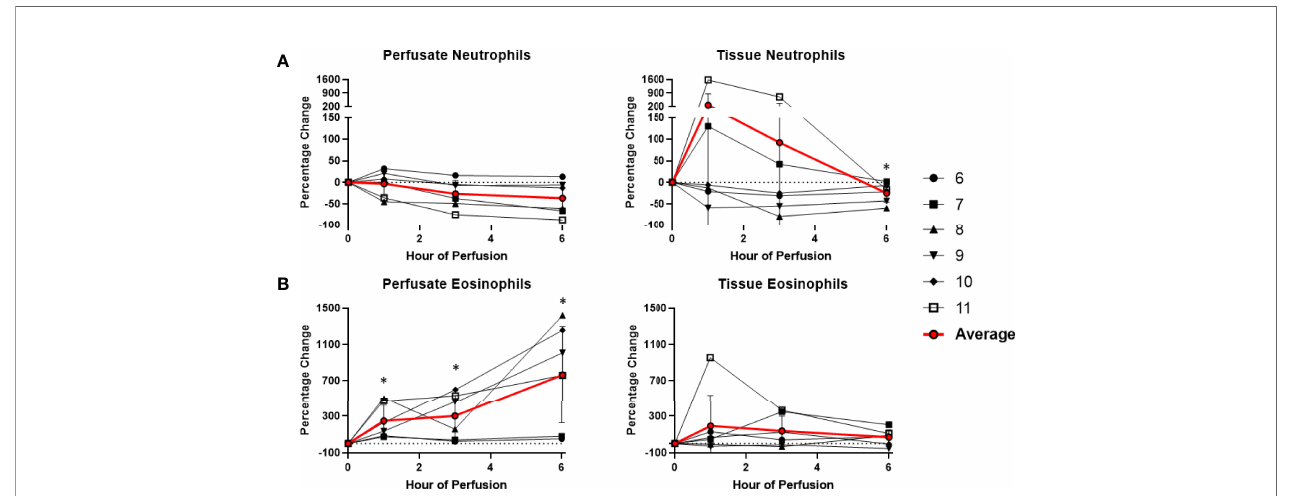
FIGURE 8 | Percentage change of frequency of cells from granulocyte lineage during perfusion. A percentage change of 0% suggests there is no change in the innate immune cell frequency from time point 0 th hour. Average values of percentage changes (red line) as well as standard deviations were calculated (vertical bar). A two-sided, paired t-test was performed to compare percentages of each time point to those at time 0H. (* P<0.05). (A) No changes were observed in perfusate neutrophil frequency but tissue neutrophil frequency decreased at the 6 th hour of perfusion (-24.5 ± 21.3%). (B) Perfusate eosinophil frequency increased at the 1 st hour of perfusion (+249.3 ± 175.3%) and continued to increase at the 6 th hour of perfusion (+763.1 ± 533.4%), without changes to tissue eosinophil